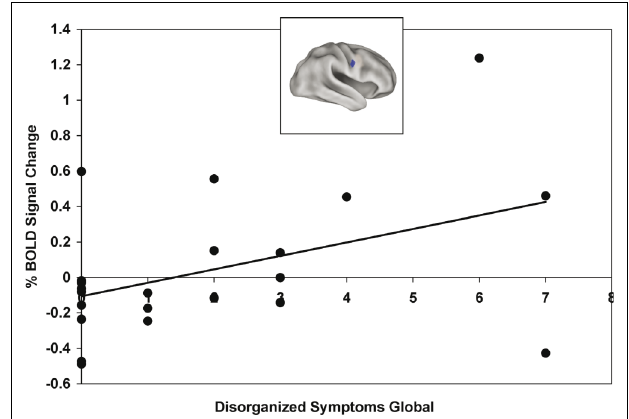
FIGURE 3 | Training-related improvement in B-Cue activation in right inferior frontal junction ( x = + 52, y = + 2, z = + 32) positively correlated with disorganized symptoms global score (includes disorientation from attention, positive formal thought disorder, and bizarre